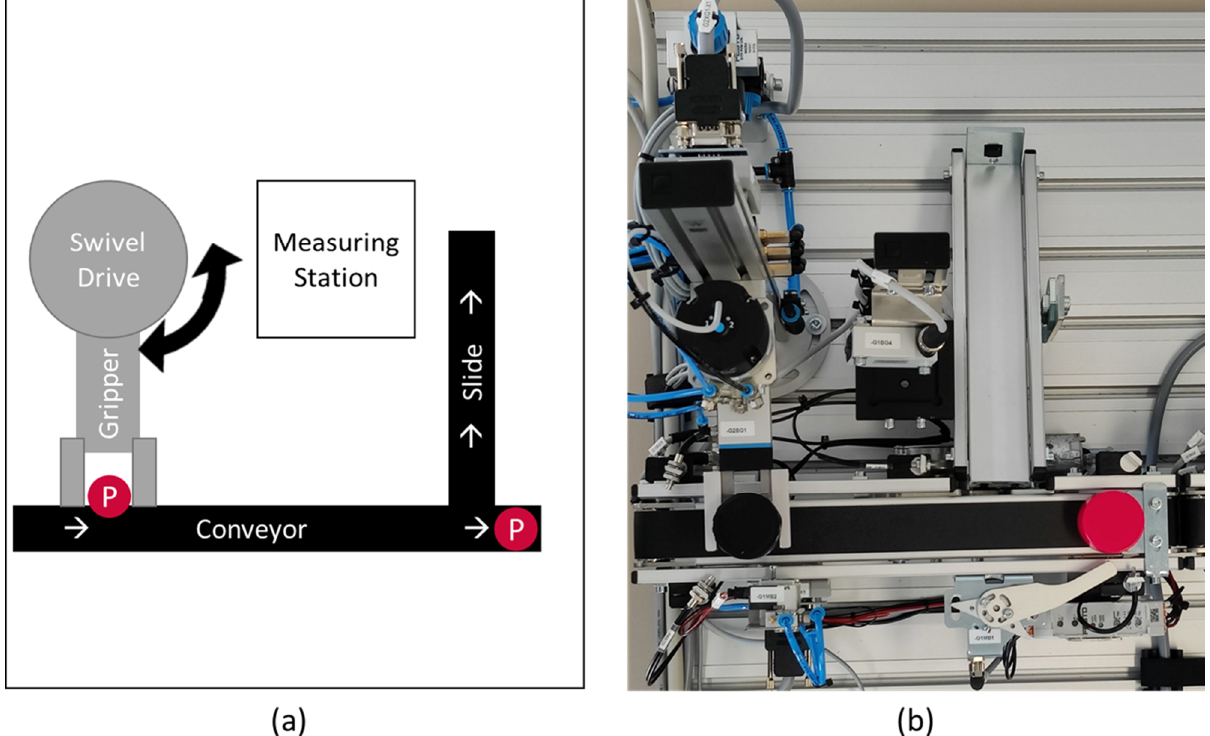
Figure 12. The figure illustrates the FA 3 ST demo setup. ( a ) a schematic representation of the real setup, showing how the gripper is picking products (P) from the conveyor and transporting them between the conveyor and the measuring station. ( b ) depicts the physical demo setup used in the use case, as described in Section 5.